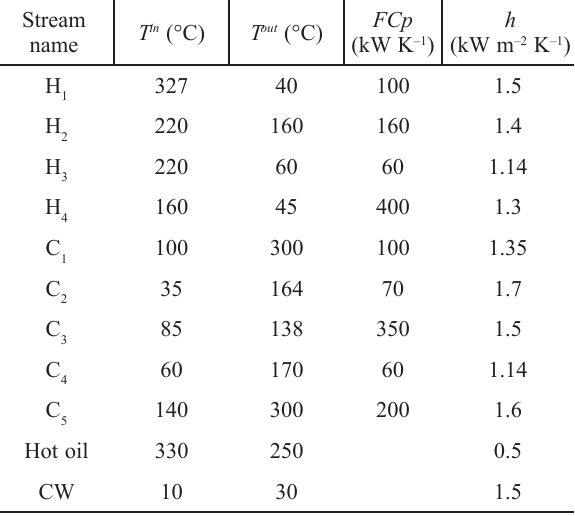
Table 1 – Thermodynamic data for case study